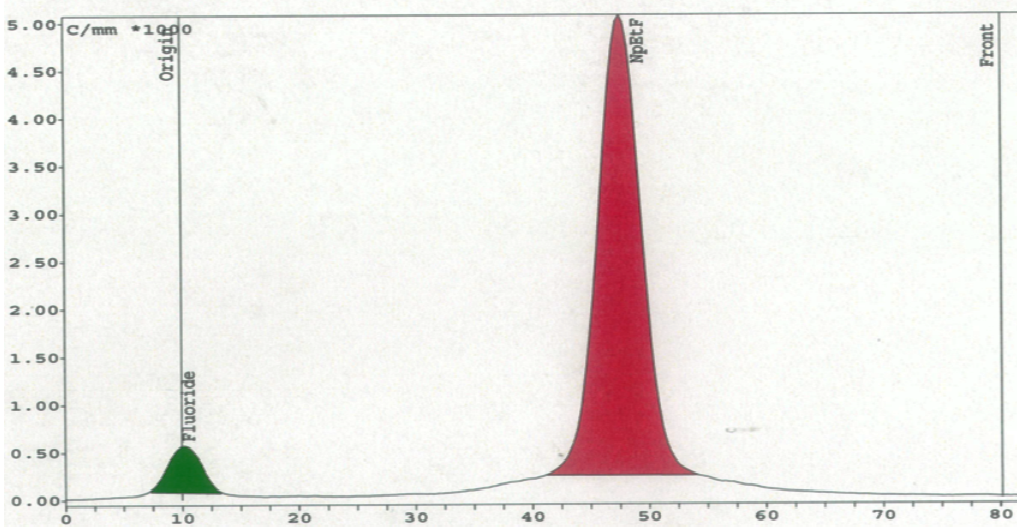
) OMs with PS -P 2tBu : 2 2